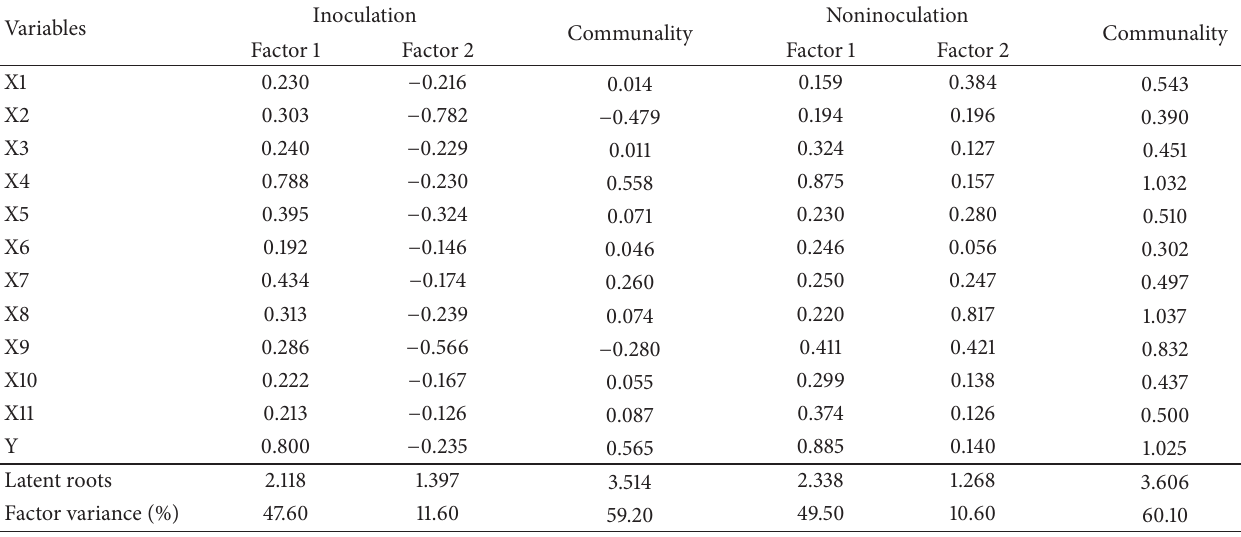
Table8:Rotated(Varimaxrotation)factorloadingsandcommunalitiesfortheestimatedvariablesofwheatbasedonfactoranalysistechnique for inoculation and noninoculation conditions and different water levels.